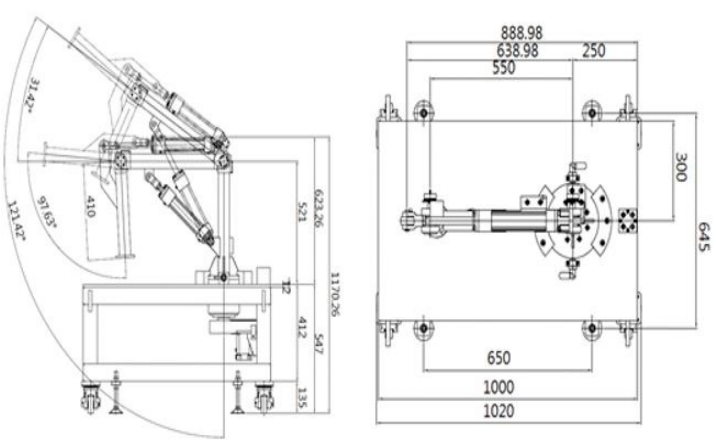
Electronics 2018 , 7 , x FOR PEER REVIEW Figure 1. Structure of the 3DOF hydraulic servo system. Figure 1. Structure of the 3DOF hydraulic servo system.